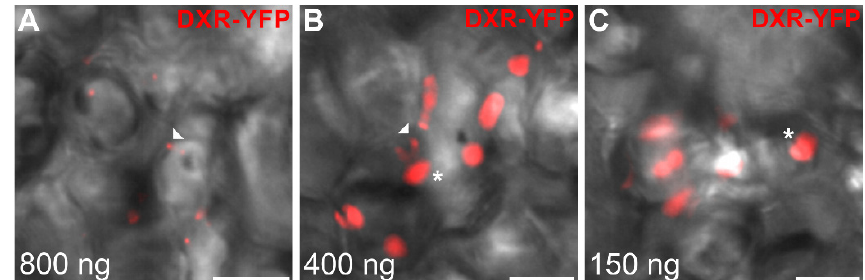
Figure 11. Transient transformation of C. roseus young leaf using a decreasing amount of the DXR-YFP expressing construct. Young C. roseus leaves were transiently transformed with decreasing amounts of the plasmid expressing DXR fused to the N-terminus of YFP as indicated at the bottom of each picture. The fluorescence emitted by YFP-fusions proteins was superimposed to cell morphology acquired using differential interference contrast. Arrowhead and star indicate punctuated and diffuse localization in plastids, respectively. (A) 800 ng; (B) 400 ng; (C) 150 ng. Bar: 10 µm.